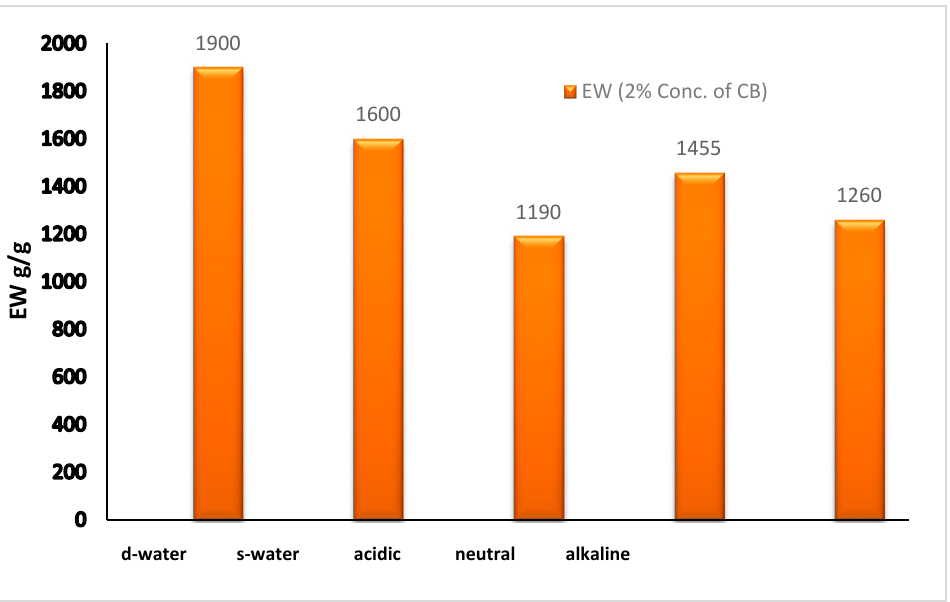
Figure 7. Swelling behavior of the IPNCB composite in different media.